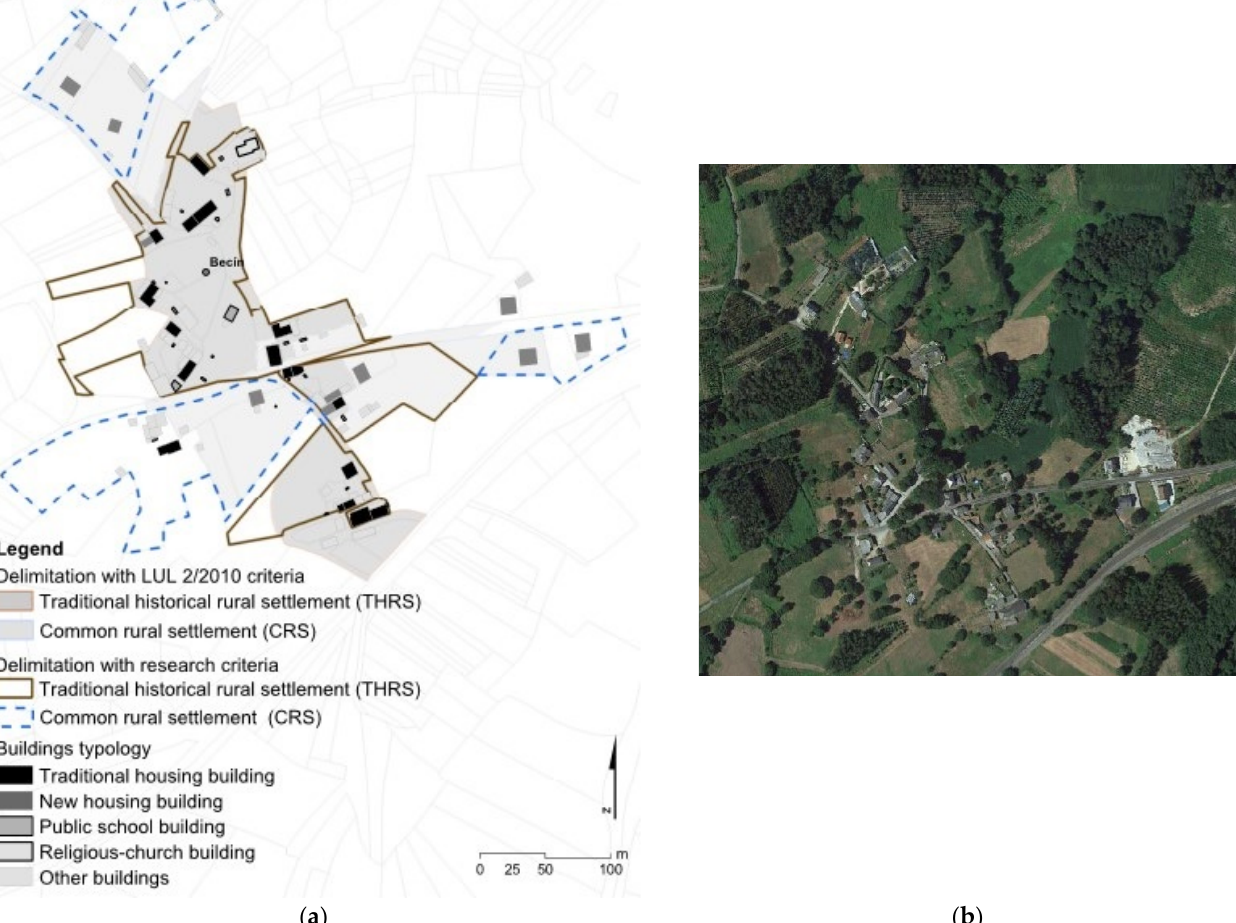
Figure 6. Delimitations according to LUL 2/2010 and the research criteria applied to RS of Becín ( a ). Aerial photo view of the RS on the right ( b ).